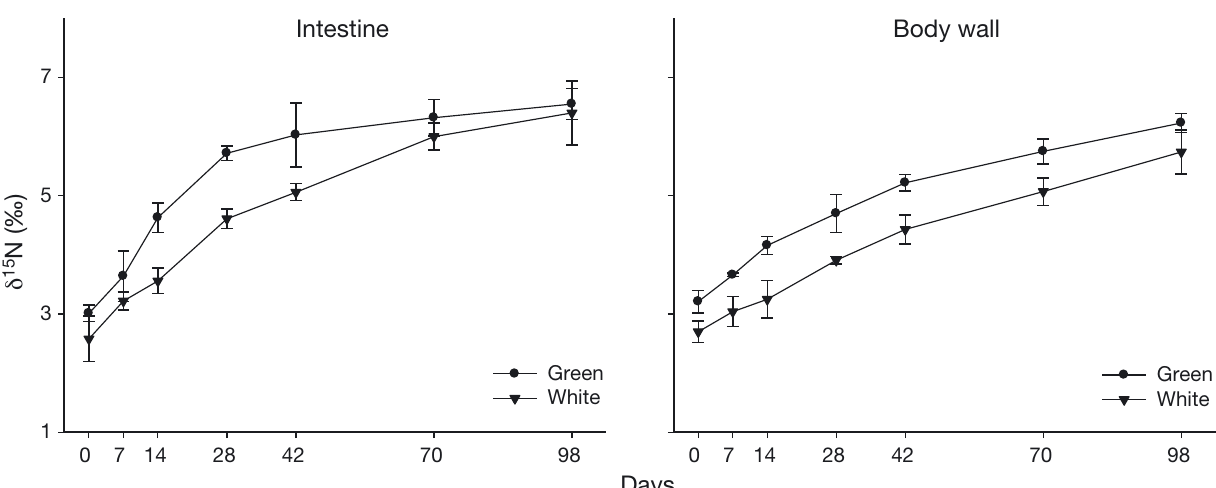
Fig. 2. Temporal changes in the observed δ 15 N values for intestine and body wall of green and white sea cucumber